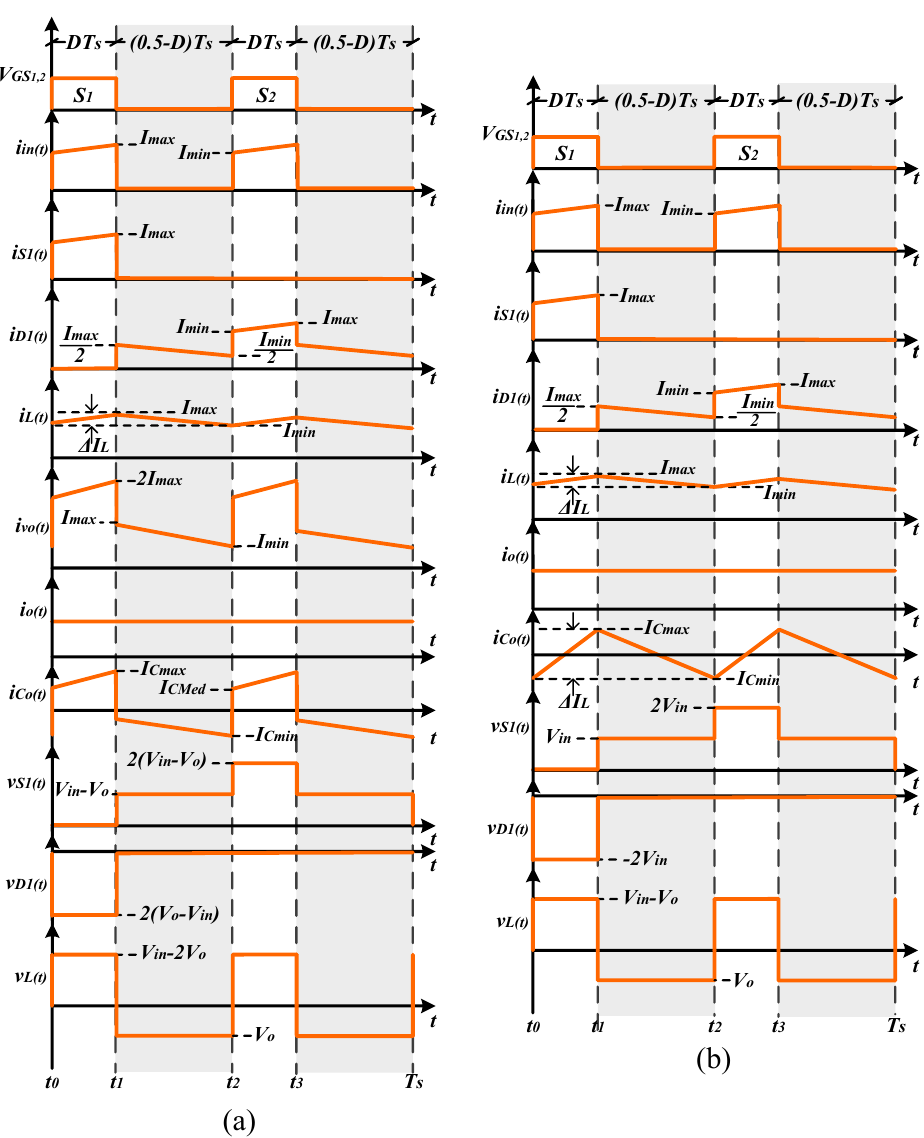
Figure 2. 3SSC-A-based step-down converters waveforms in CCM: ( a ) 3SSC-A-based buck; ( b ) 3SSC- A-based